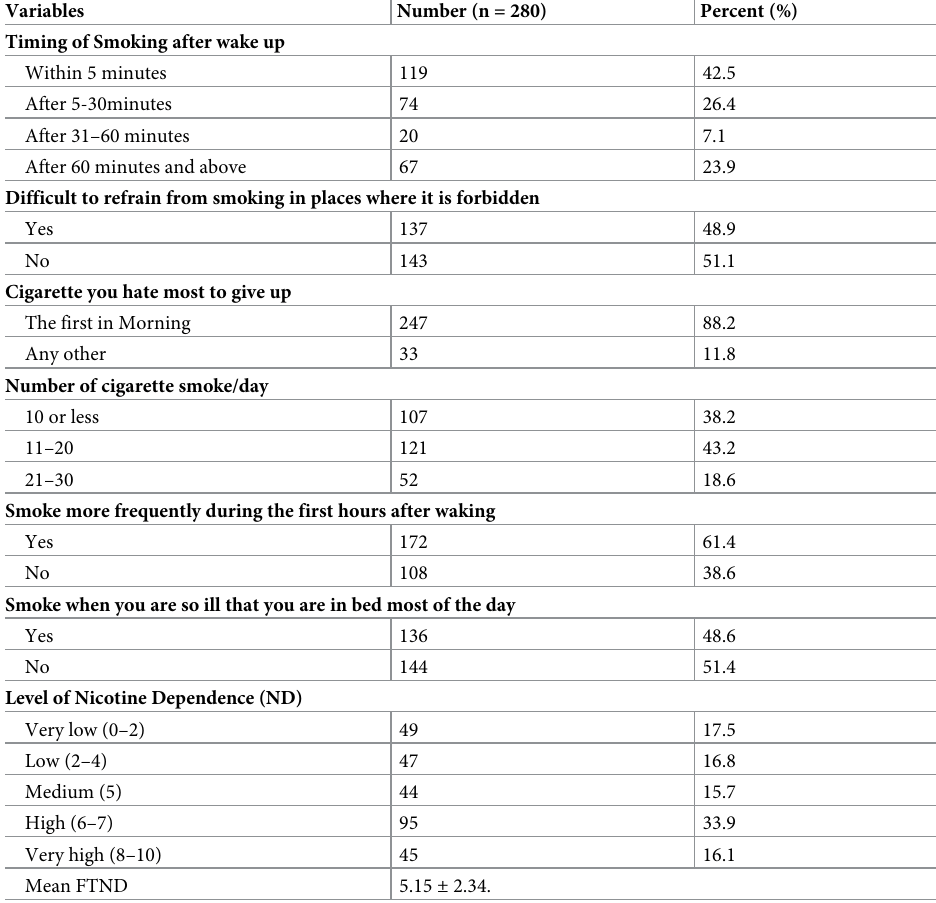
Table 2. Nicotine